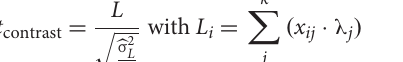
Refer to Figure 5 . Thresholds for identifying 90 ◦ were lower than Baseline in the unperturbed condition in both Post Training ( M = 14.58 ◦ , SD = 4.92 ◦ ) and Retention ( M = 14.89 ◦ , SD = 5.77 ◦